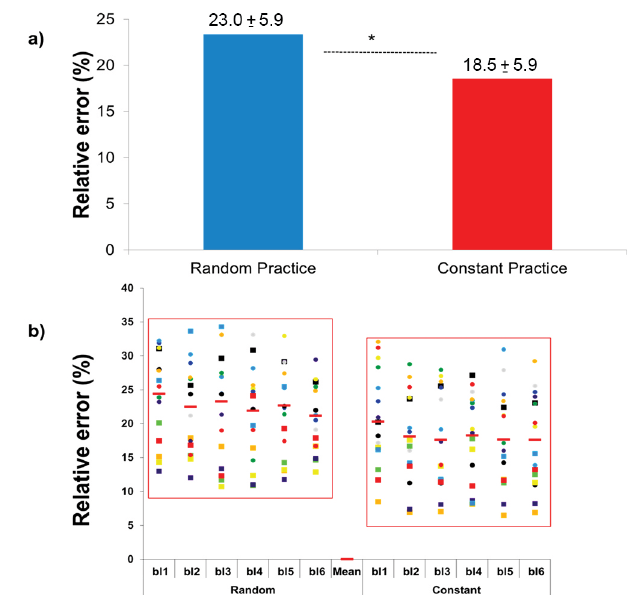
Figure 1. Relative error: ( a ) means of the relative error in the random and constant practice conditions, and ( b ) inter-subject variability over the blocks of trials (bl1 … bl6) during both the random and constant practice conditions ( * represents significant difference).